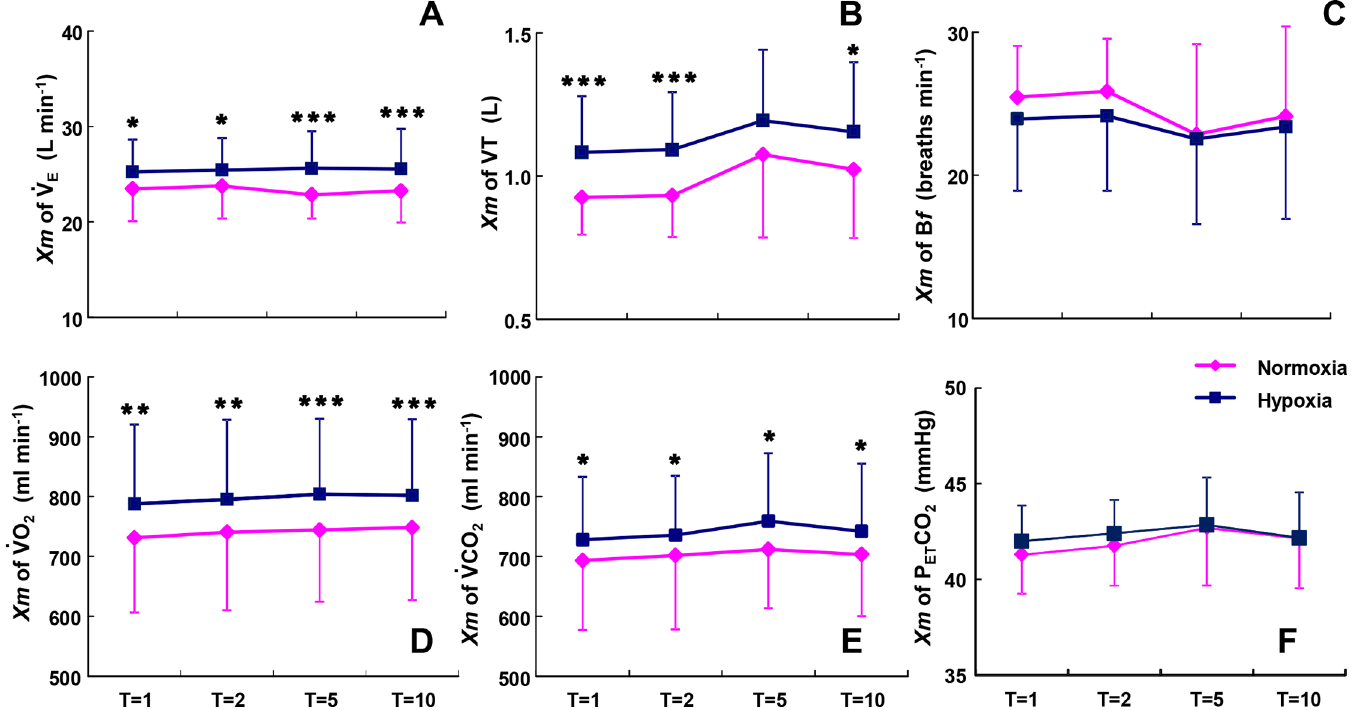
Fig 5. Comparison of the mean values of ventilatory and gas exchange kinetics between hypoxia and normoxia. Differences in Mx between hypoxia (blue line) and normoxia (red lines) are shown as a function of the periods of the sinusoidal changes in the treadmill speed. (cid:3) p < 0.05, (cid:3)(cid:3) p < 0.01, (cid:3)(cid:3)(cid:3) p < 0.001 for hypoxia vs. normoxia. Data are means ± SD.